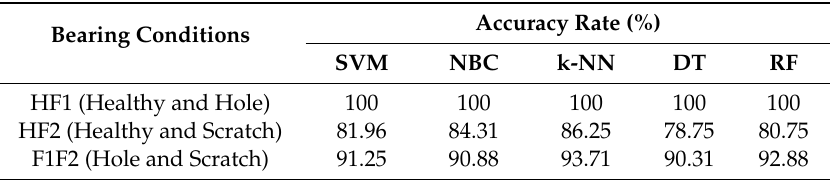
Table 2. Diagnosis result of ML